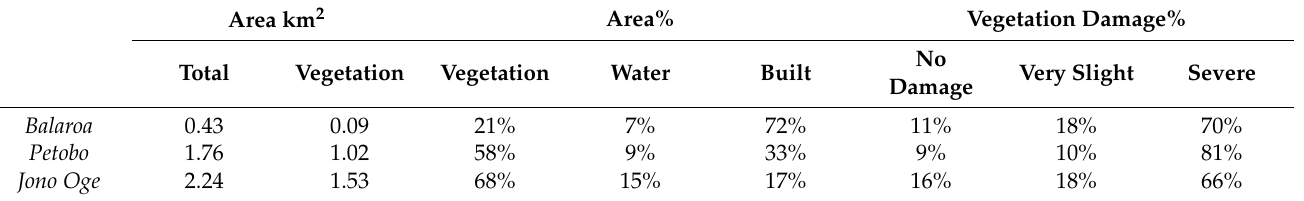
Table 4. Summary of the damaged rural areas in Palu valley. Built-up, vegetation, and water body areas are included in the data. A detailed description of the damaged vege- tation is provided along with the damage level.